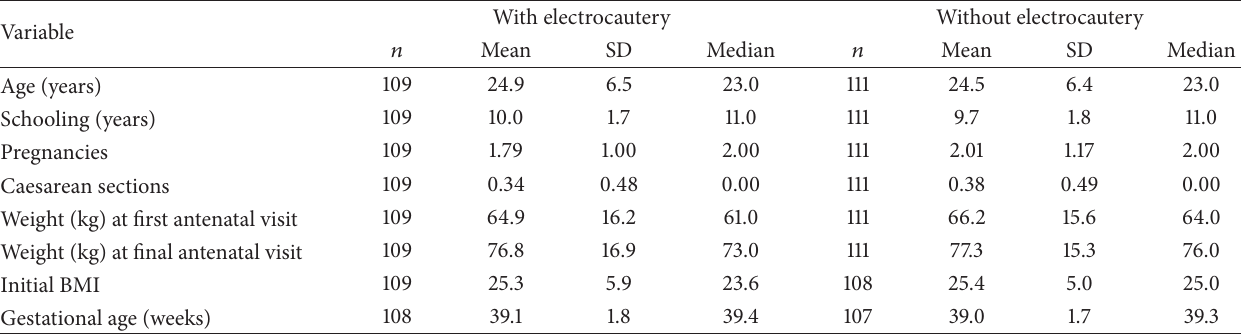
Table 1: Demographic characteristics, parity, and prenatal care in pregnant women submitted to C-sections with and without the use of electrocautery.